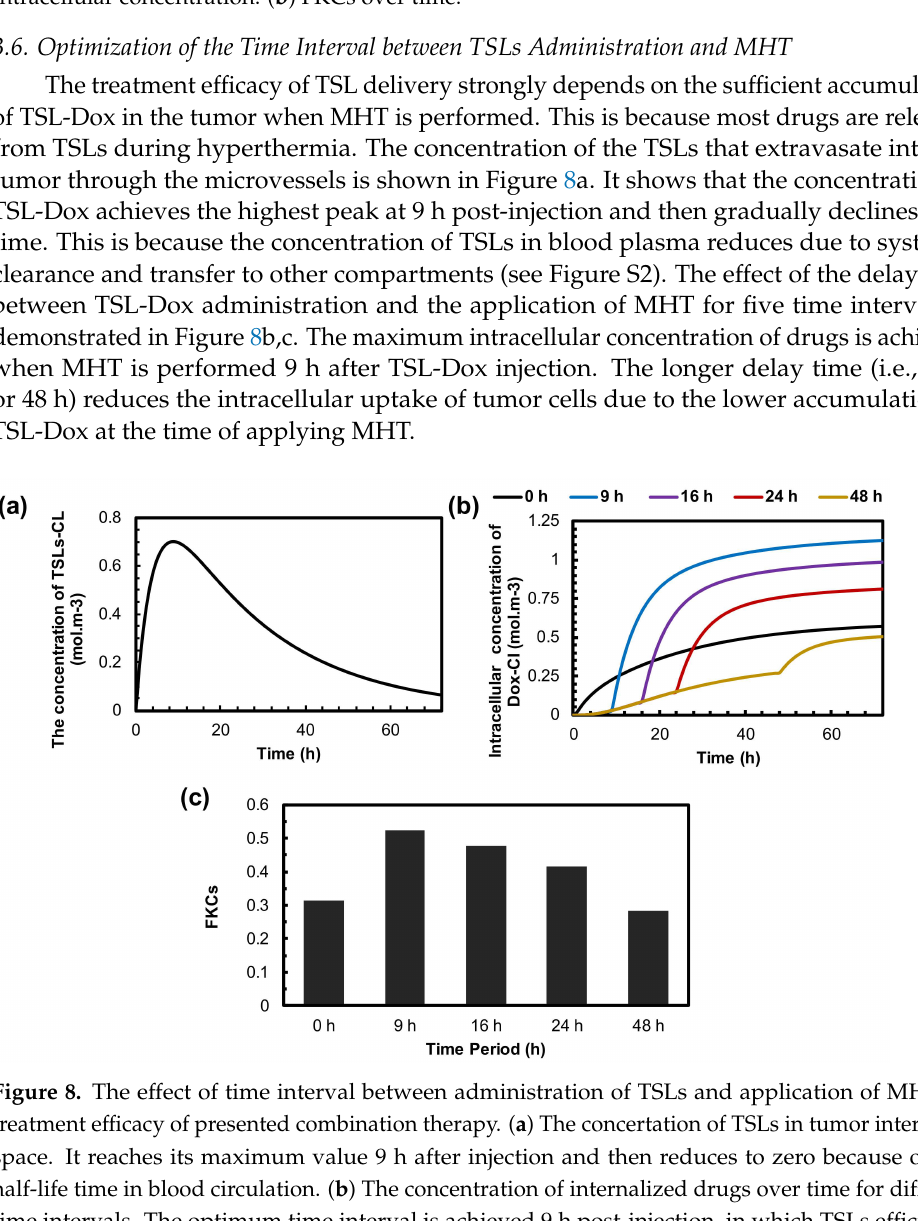
Figure 7. The effect of drug dosage on treatment efficacy of presented combination therapy. ( a ) Intracellular concentration. ( b ) FKCs over time.